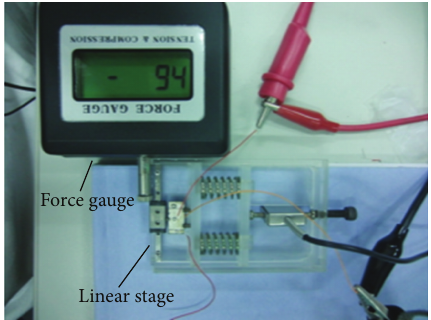
Figure 6: The detailed dimensions of the large thrust piezoelectric actuator.